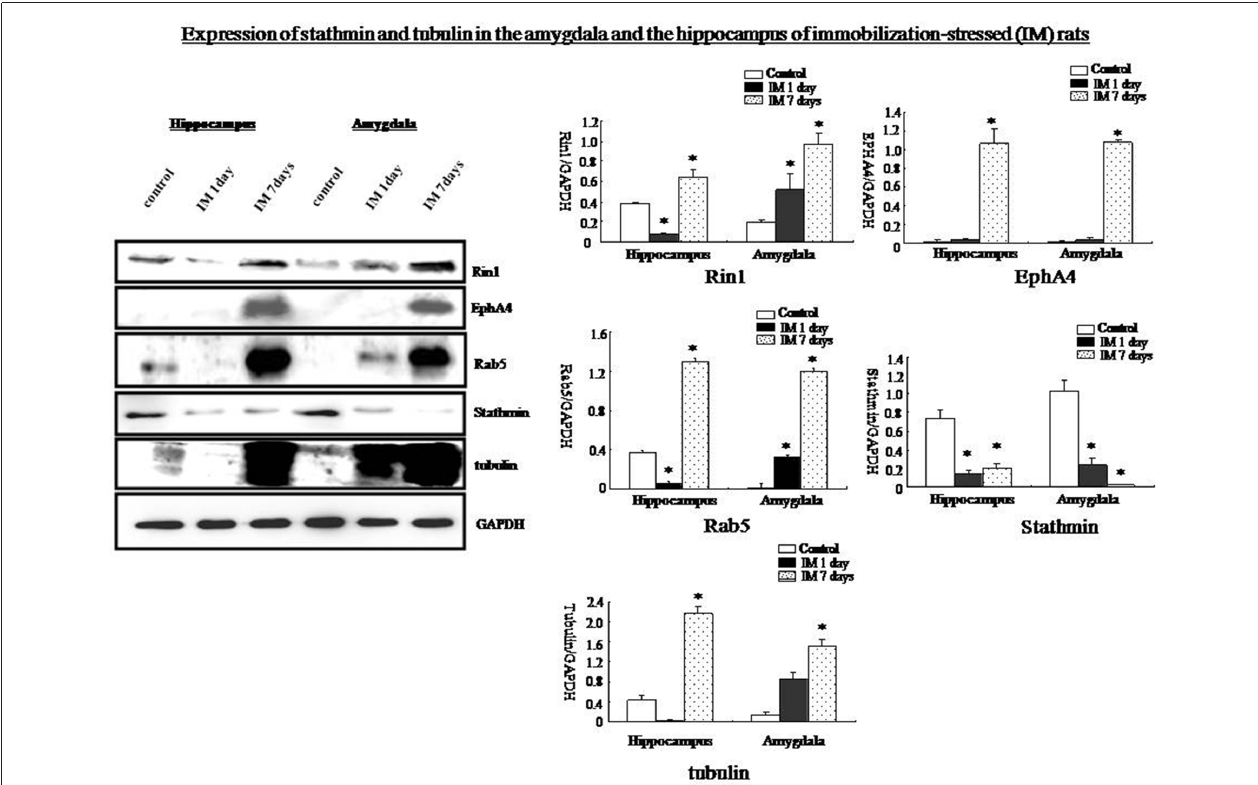
FIGURE 9 | Western blots showing that Rin1, EphA4, Abl, Rab5, and tubulin expression increased significantly in the amygdala and hippocampus 7 days after the IM-stress stimulation compared with the control rats; in contrast, stathmin expression decreased. Quantification of western blots showing lower expression of Rin1, EphA4, Rab5, and tubulin in the amygdala and hippocampus of the IM 1 day group and higher expression in the IM 7 days group compared with the control group except stathmin ( ∗ P < 0.05 vs. the control group).